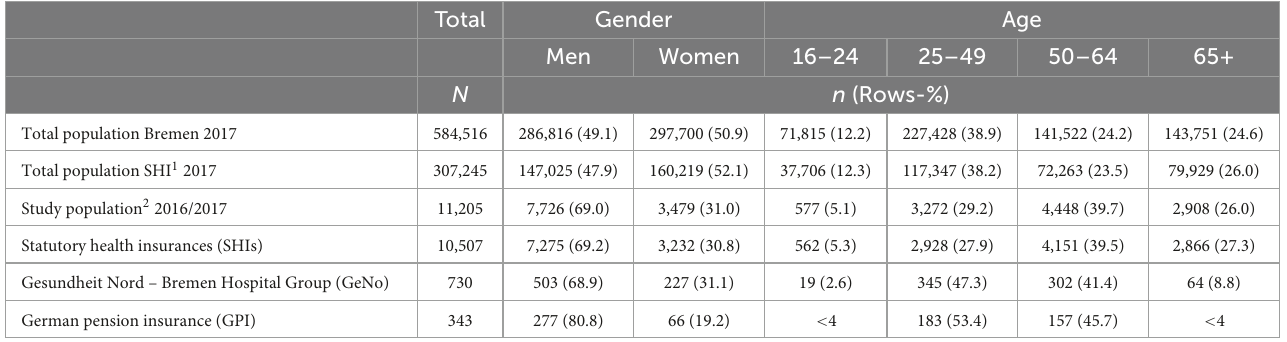
TABLE 1 Overview of study and total population.